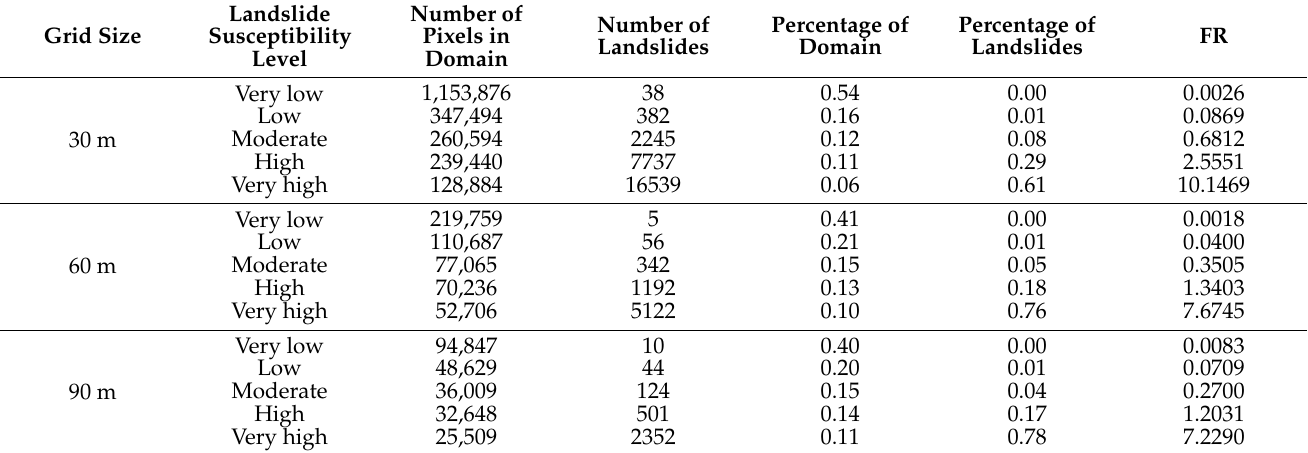
Table 3. RF zoning model of landslide susceptibility.